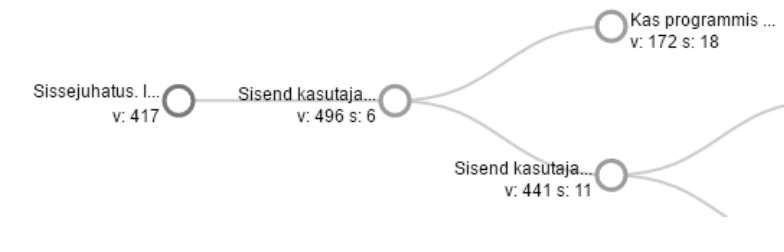
Figure 5 . Tree graph with the statistics of a